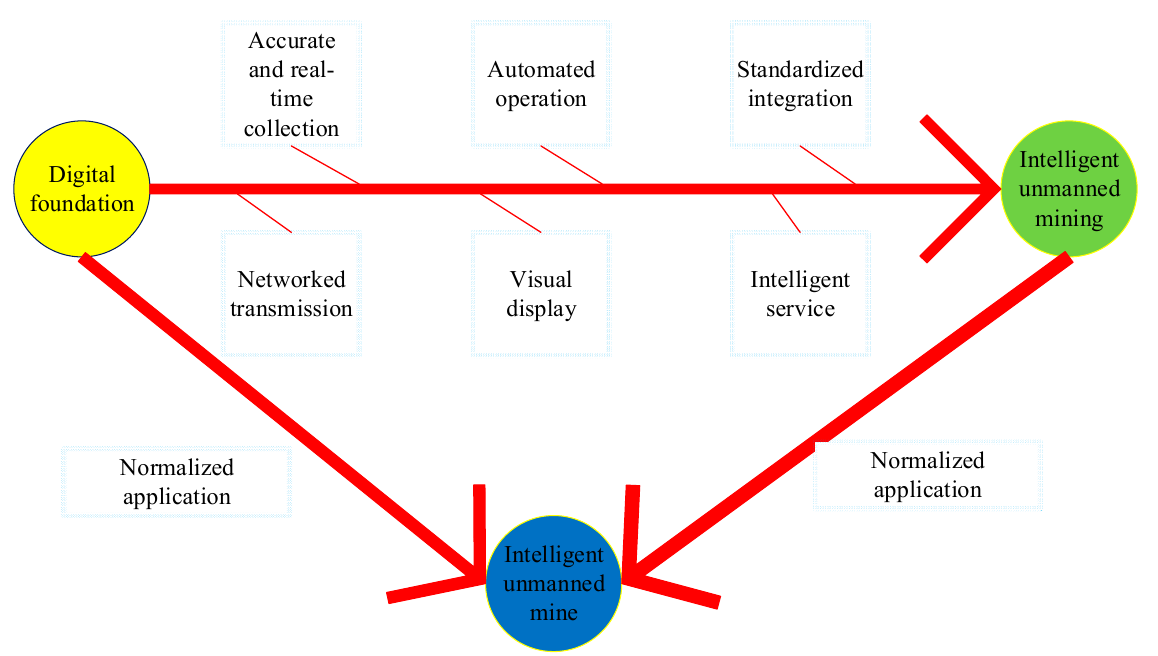
Figure 9. System diagram of the overall design architecture of intelligent unmanned mining.